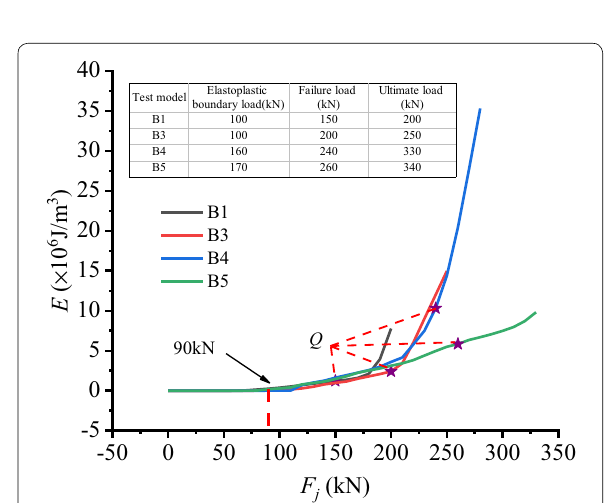
Fig. 16 The E – F j curves of RC beams with different reinforcement